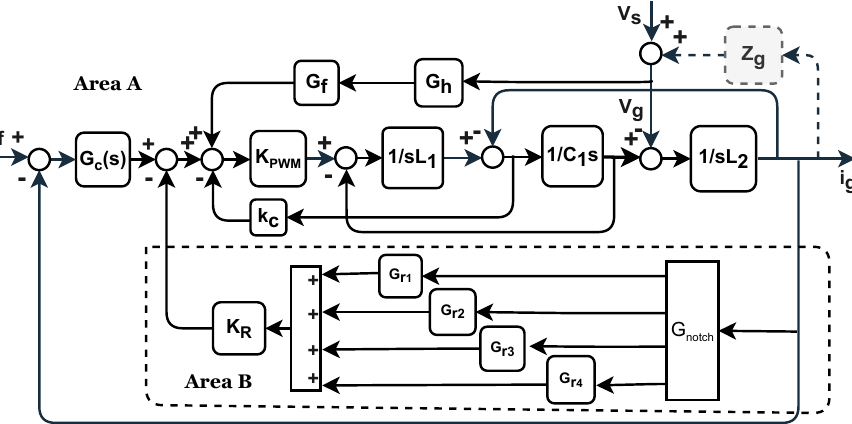
Figure 8. The proposed design of GTI with adaptive hybrid control